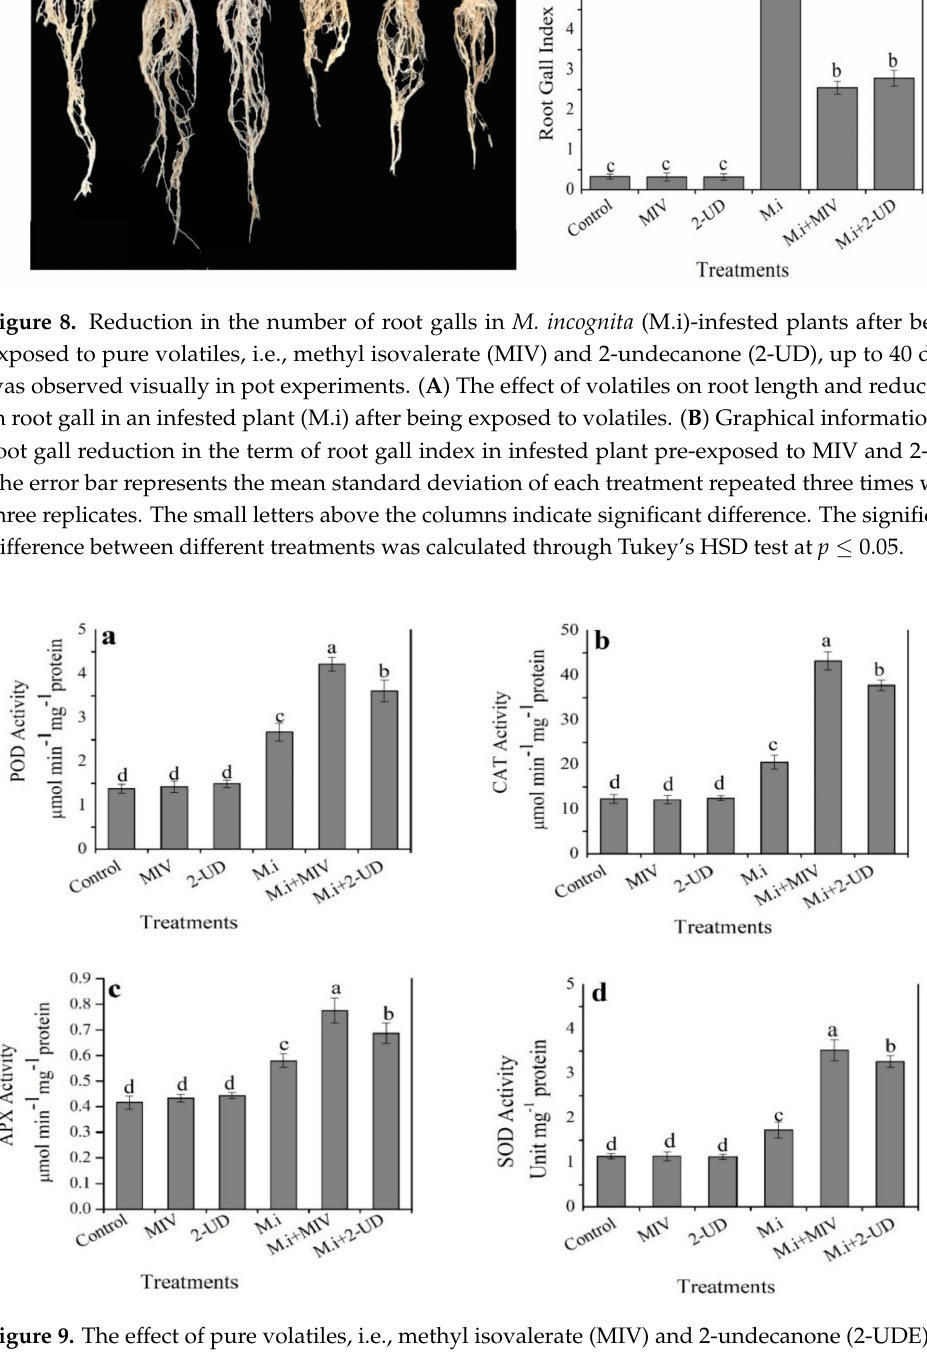
Figure 9. The effect of pure volatiles, i.e., methyl isovalerate (MIV) and 2-undecanone (2-UDE), on antioxidant enzymes. ( a – d ) Activity in M. incognita- infested and non-infested tomato plant roots. The root samples of different treatments were taken at 4 dpi to obtain enzyme extract. Error bar represents the mean standard deviation of three repeats with three replicates for each treatment. The small letters above the columns indicate significant difference. The significant difference among the treatments was calculated through Tukey’s HSD test at p ≤